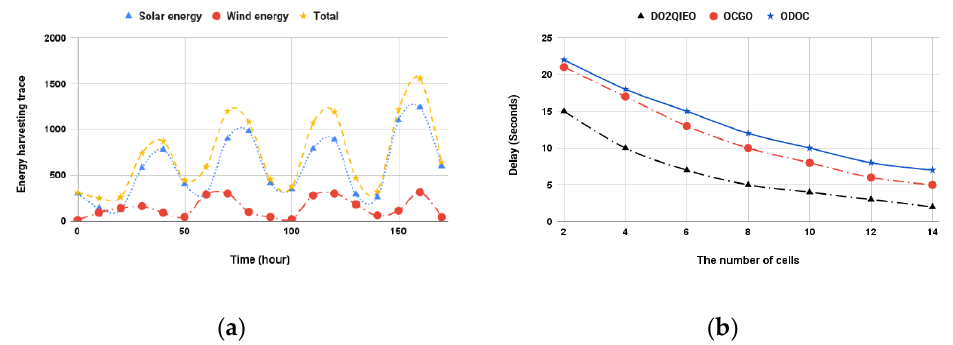
Figure 8. DO2QIEO technique performance in online mode ( a ) energy harvesting performance over time ( b ) delay of IoT tasks for given number of cells with EH (Figure ( a ) is on the left, Figure ( b ) is on the right ( b )).